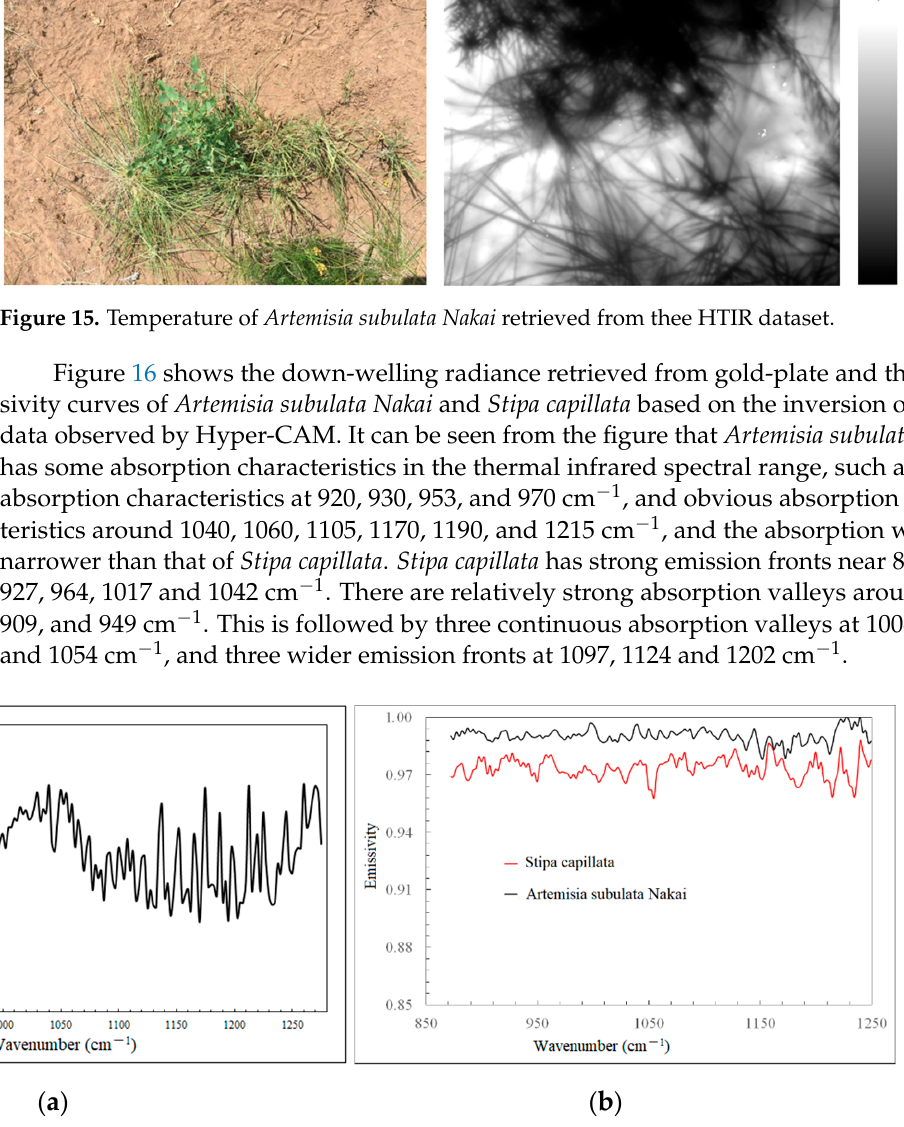
Figure 16. Results of emissivity retrieval and the down-welling radiance. ( a ) is the down-welling radiance retrieved from the gold-plate and ( b ) the emissivity of Artemisia subulata Nakai and Stipa